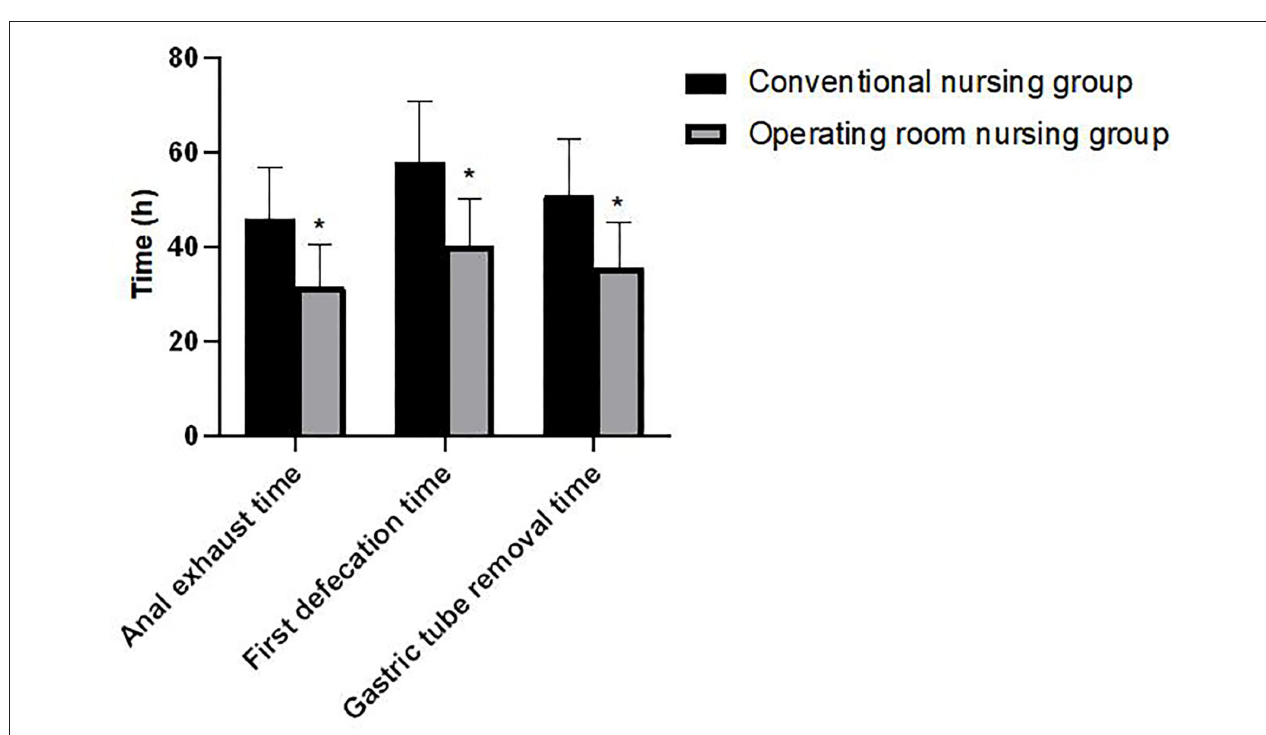
FIGURE 2 | Comparison of wound healing between the two groups. Compared with the conventional nursing group, * p < 0.05.